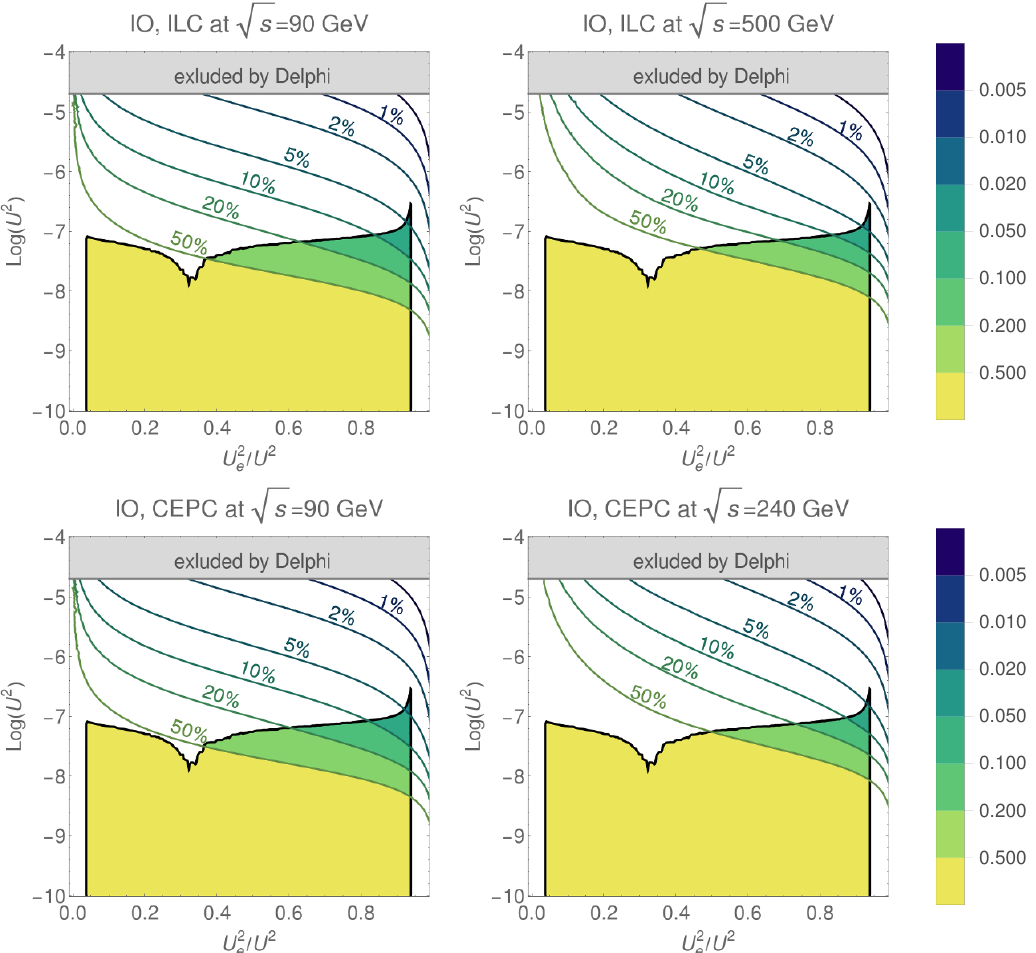
Figure 8 . The colour indicates the precision that can be achieved for measuring U 2 p p ILC with s = 90 GeV (top, left) and s = 500 GeV (top, right), as well as at the CEPC with p p s = 90 GeV (bottom, left) and s = 240 GeV (bottom, right) for the case of inverse ordering (IO) of the light neutrino masses. It turns out that besides the FCC-ee, cf. (cid:12)gure 7, only the four channels displayed here can be tested with precision better than 50 %. All other channels, e.g. the ones that test U 2 =U 2 and U 2 =U 2 at the ILC and CEPC are not plotted here because the precision (cid:22) (cid:28) that can be achieved is below 50 % for all values of U 2 consistent with leptogenesis. The two heavy neutrinos are assumed to be almost degenerate in mass at M = 10 GeV. Details are given in the main text, cf. section